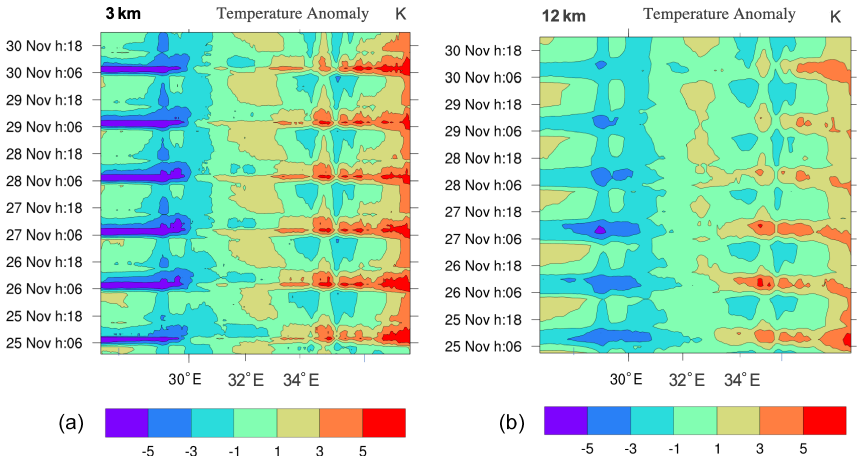
Figure 10. Longitude–time (hourly) Hovmöller diagram of LKV domain surface temperature anomaly (shading, in K). Panels correspond to the 3km simulation (a) and 12km simulation (b) . Lake Victoria is situated between 32 and 34 ◦ E longitude.